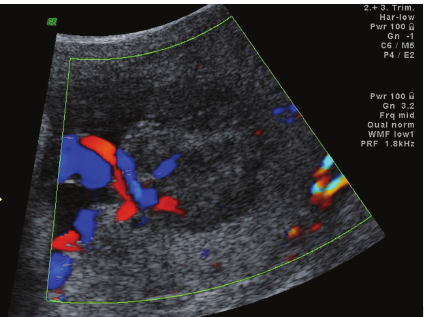
Figure 5: The color Doppler ultrasonography of Case 2 showing the typical place of the tumor next to the umbilical cord